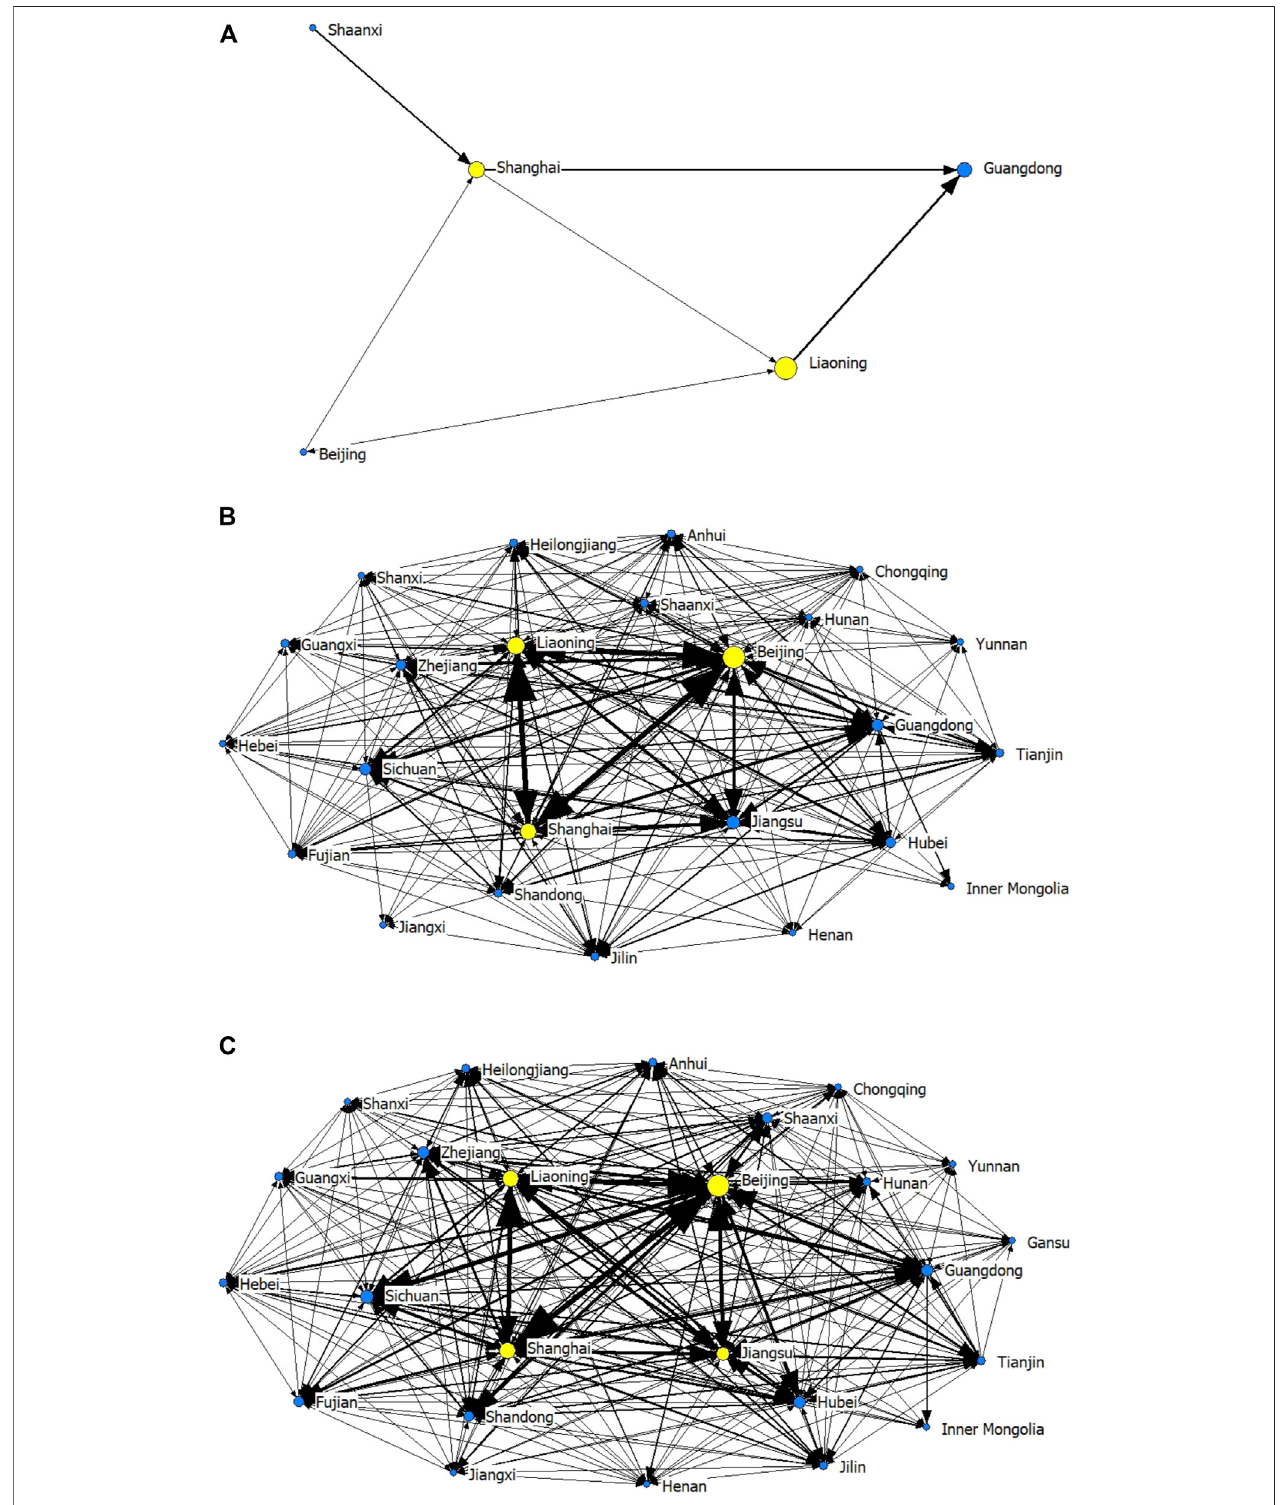
FIGURE 5 | Evolution of China ’ s HFCV patent citation network for the three periods. (A) (2001 – 2006), (B) (2001 – 2016), (C) (2001 – 2020). Note: Node represents the province. Node ’ s color represents node ’ s activity level. Yellow node means core province. Blue node means periphery province. The arrowed line between nodes represents the patent citation relationship between provinces. The direction of the arrowed line represents the fl ow of the knowledge.